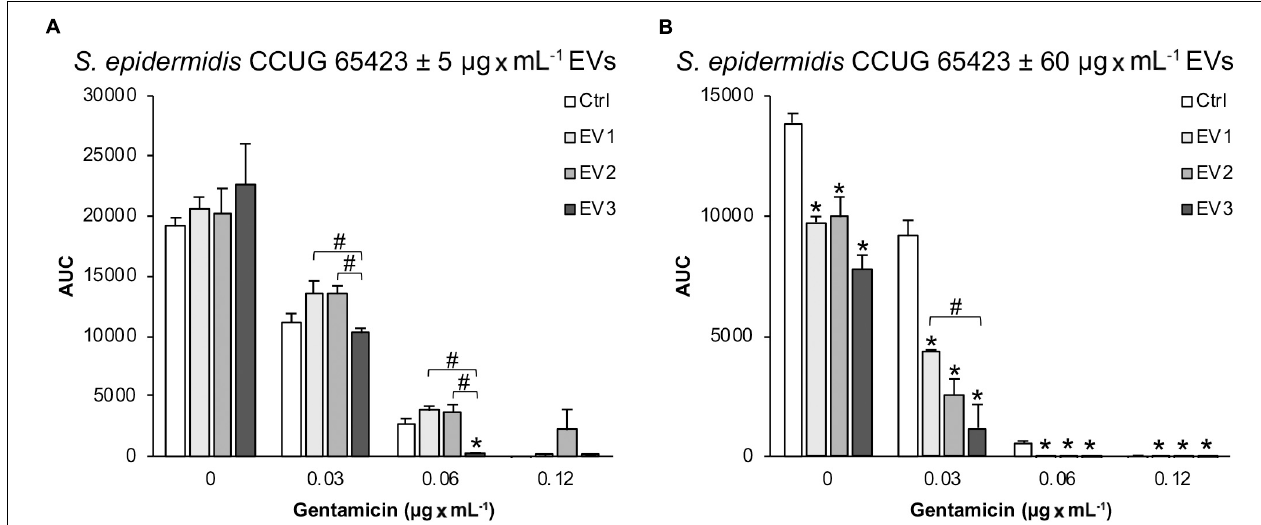
FIGURE 3 | The total growth of Staphylococcus epidermidis CCUG 64523 in four different culture conditions (0, 0.03, 0.06, and, 0.12 µ g × mL − 1 GEN) calculated as the AUC after 18 h of culture with (A) 5 µ g × mL − 1 EVs and (B) 60 µ g × mL − 1 EVs. The data represent the mean ± SEM ( n = 3); *indicates a significant difference compared to the Ctrl; # indicates a significant difference between different EV-stimulated groups with p <